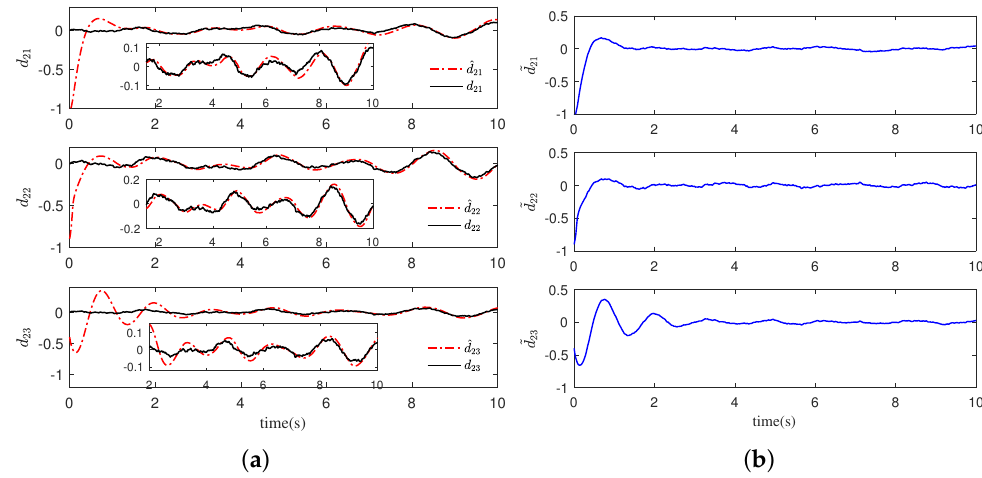
Figure 4. Fast-loop disturbance estimation response curve of the NDO: ( a ) d 2 and ˆ d 2 (rad/s 2 ); ( b ) the estimation error ˜ d 2 (rad/s 2 ).